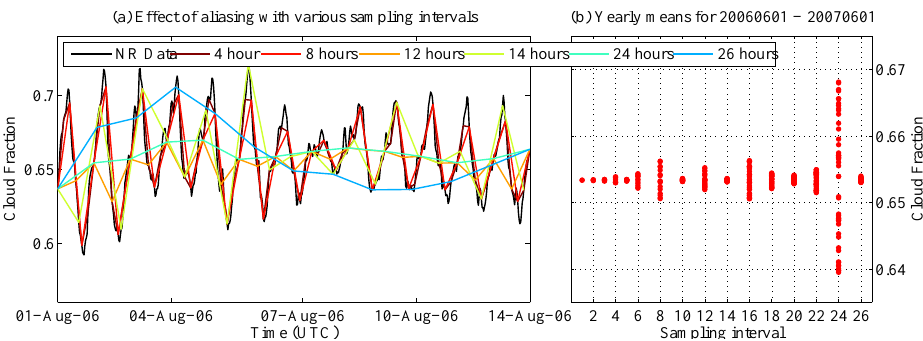
Figure 8. ( a ) The time series of sunlit ocean cloud fraction for the two week period beginning 1 August 2006 at 0000 UTC—curves show different sampling frequency but with the same starting point; ( b ) The mean for the year beginning 1 June 2006 at 0000 UTC for different sampling frequencies and all possible starting points.